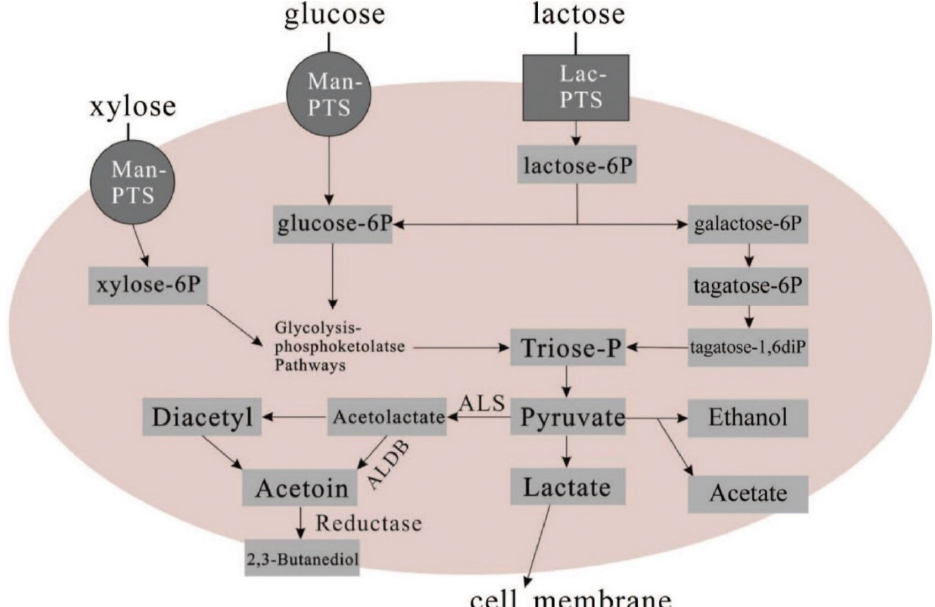
Figure 5. Generation of VOCs in carbohydrate metabolism during milk fermentation by Lactobacillus pentosus . (Reproduced with permission from Elsevier [145].) pentosus . (Reproduced with permission from Elsevier